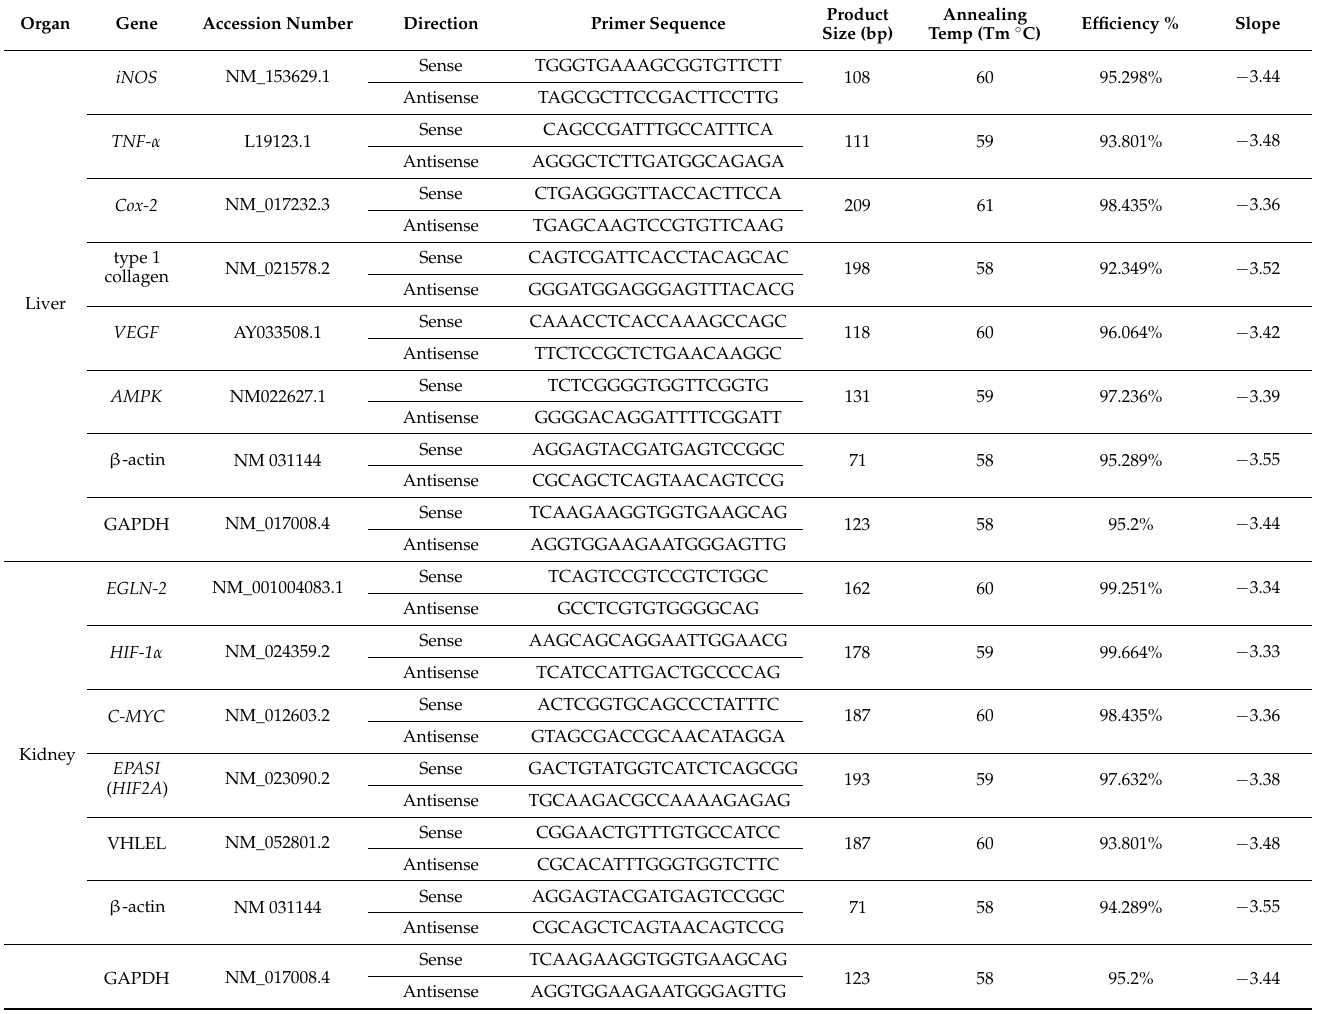
Table 1. Primer names, gene accession numbers, and sequences used for quantitative real-time PCR in